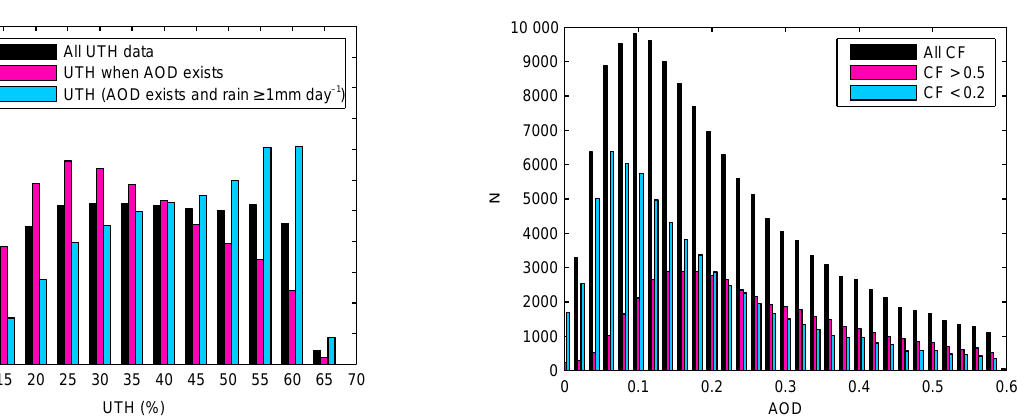
Figure 2. Number of data. Histograms of the UTH data east of China in June, July and August in 2007–2013. AOD cannot be re- trieved in the presence of clouds, which means that we were lacking part of the data with the highest values of UTH. AOD was retrieved in approximately one-third of the grid cells, in 106580 data points of the total 350407. When we limited our study to cases with pre- cipitation ≥ 1mmday − 1 , we had 17318 data points and the relative number of low UTH values decreased. UTH is strongly linked to precipitation, as both depend on the activity of convection.